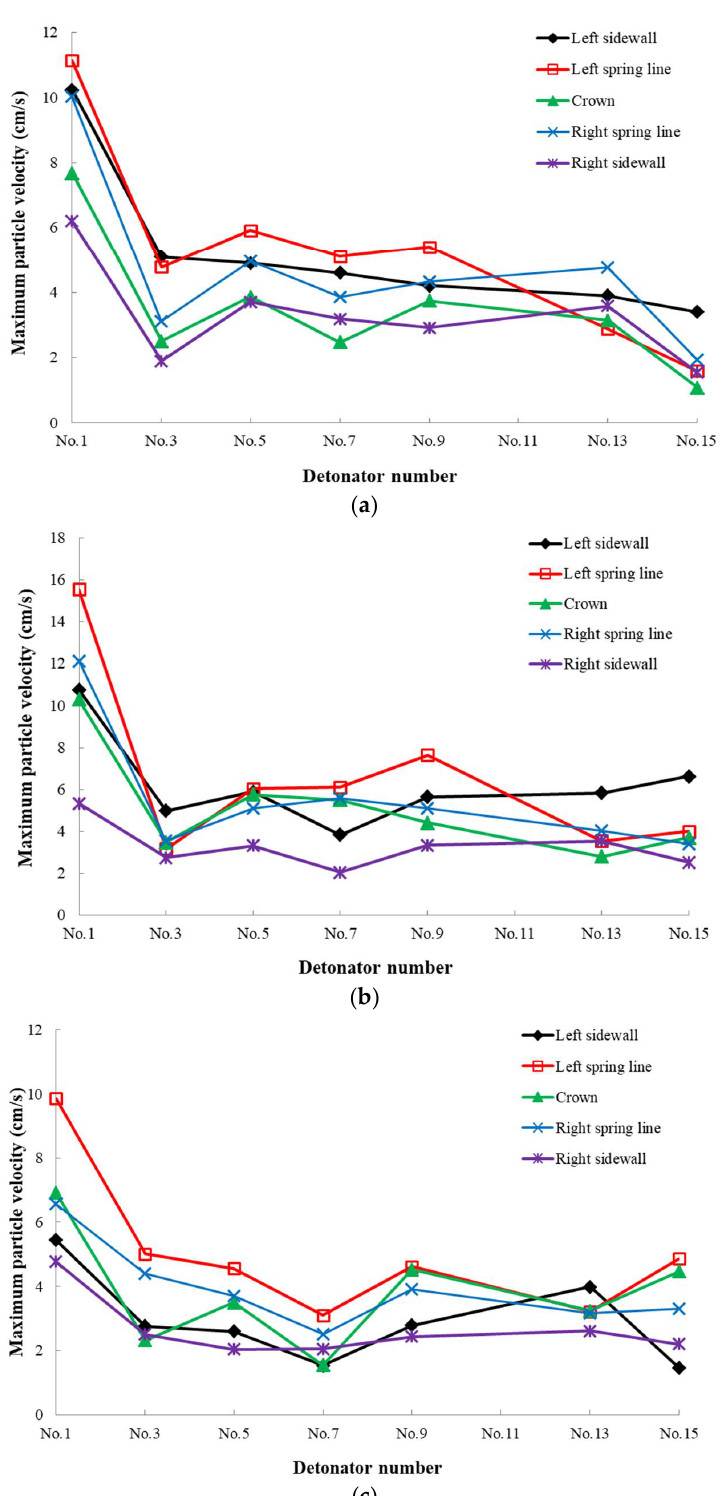
Figure 9. Maximum reluctant particle velocity for each delay in different blasts. ( a ) Maximum particle velocity vs. detonator number (delay time) when the blast source was ZK14 + 976.6; ( b ) maximum particle velocity vs. detonator number (delay time) when the blast source was ZK14 + 973; ( c ) maximum particle velocity vs. detonator number (delay time) when the blast source was ZK14 + 970.